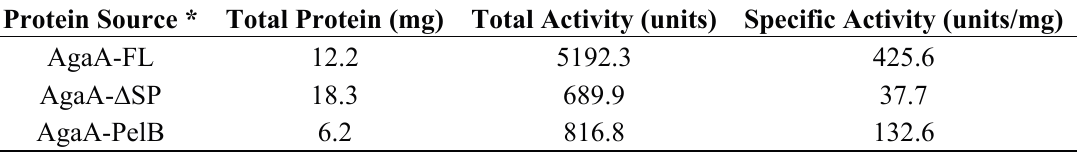
Table 1. Agarase activity of recombinant AgaA from P. vesicularis